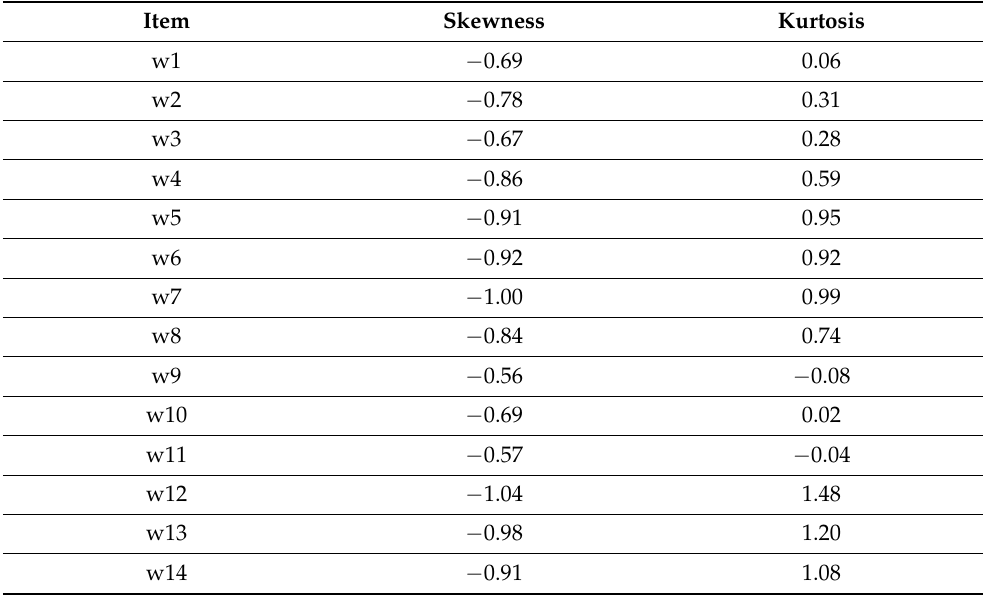
Table 4. The Observed Variable’s Skewness and Kurtosis in Recreational Sport Well-being Scale.